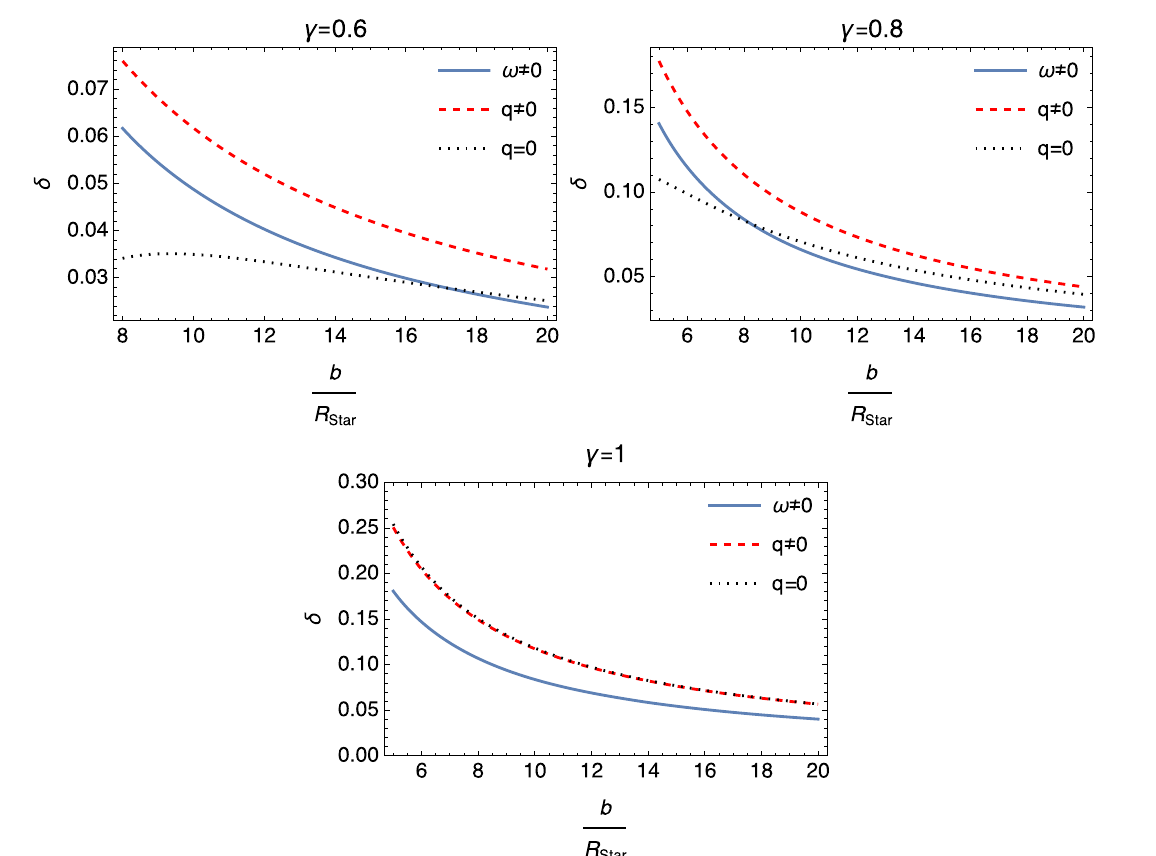
metrics. Variation for each case are shown on the same graph for dif- ferent values of deformation parameter